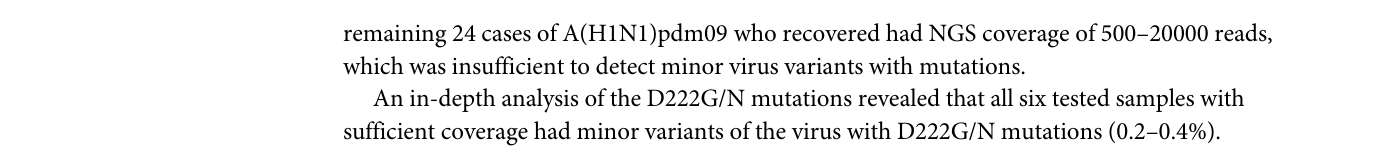
The table shows the percentage of virus variants with the mutations in the sample. � -value is below detection limit.